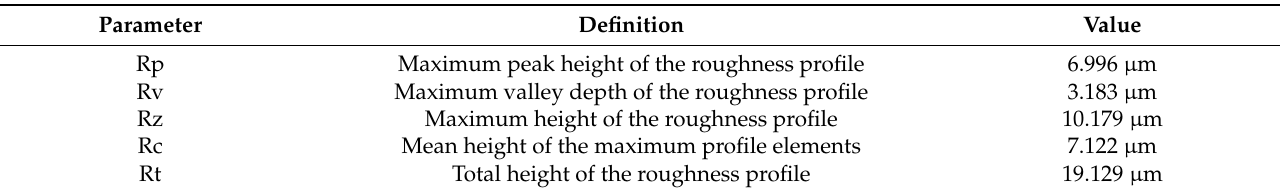
Figure 7. Roughness profile of the surface of one of the PCLF: ( a ) Upper view of the fiber; ( b ) 3-D view of the fiber; ( c ) Profile along one section line of the fiber. Table 4. Roughness parameters definitions and